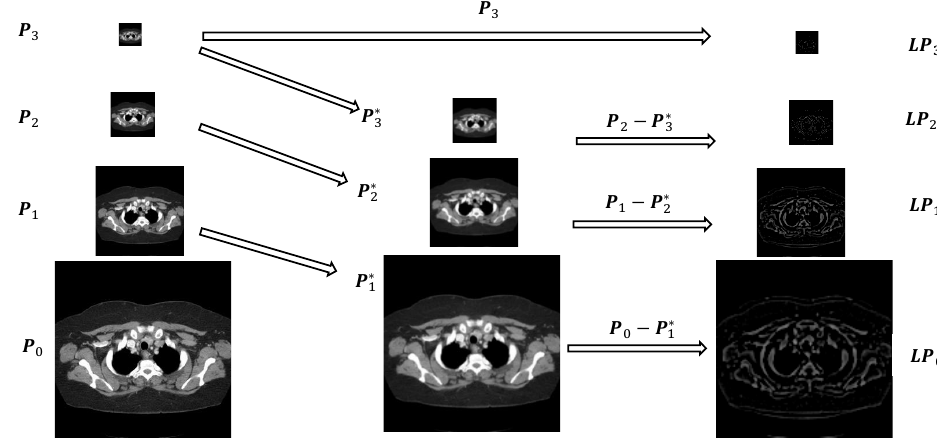
Figure 3. Decomposition using the Laplacian